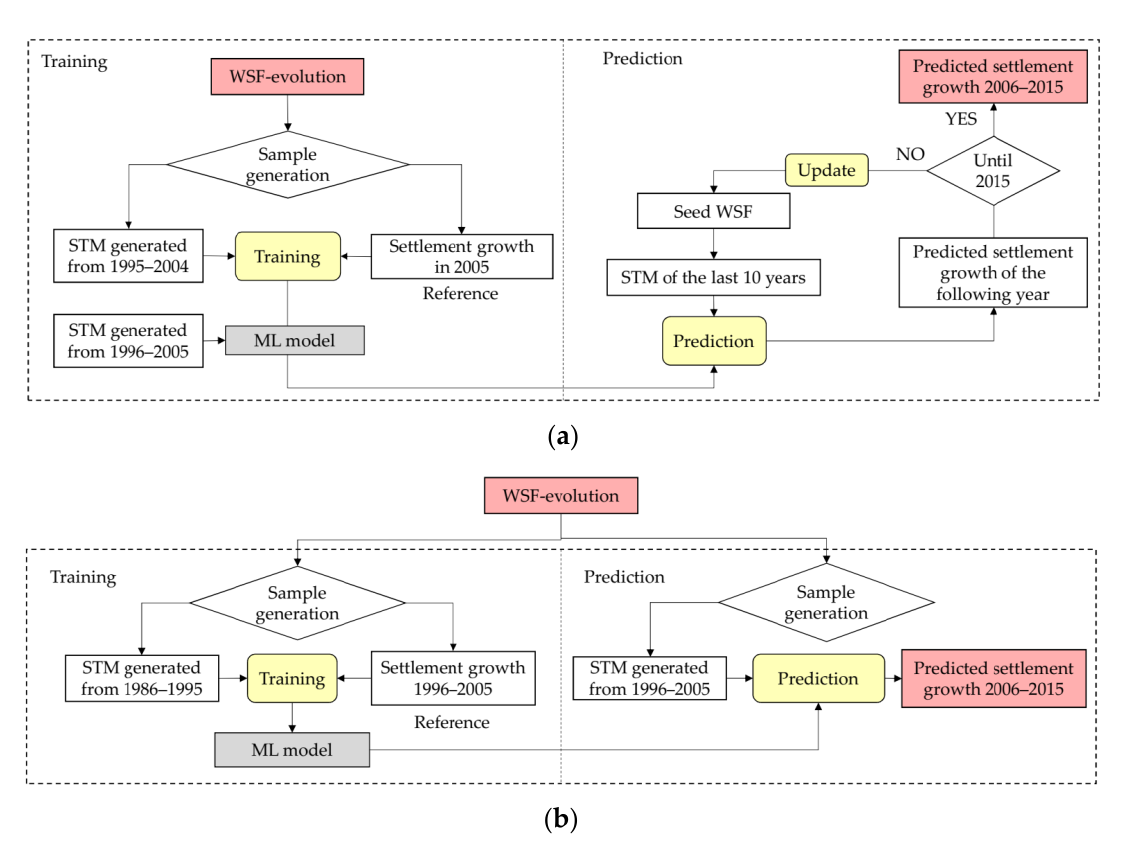
Figure 6. Workflow of two strategies: ( a ) workflow of the one-year strategy and ( b ) workflow of the ten-year strategy.